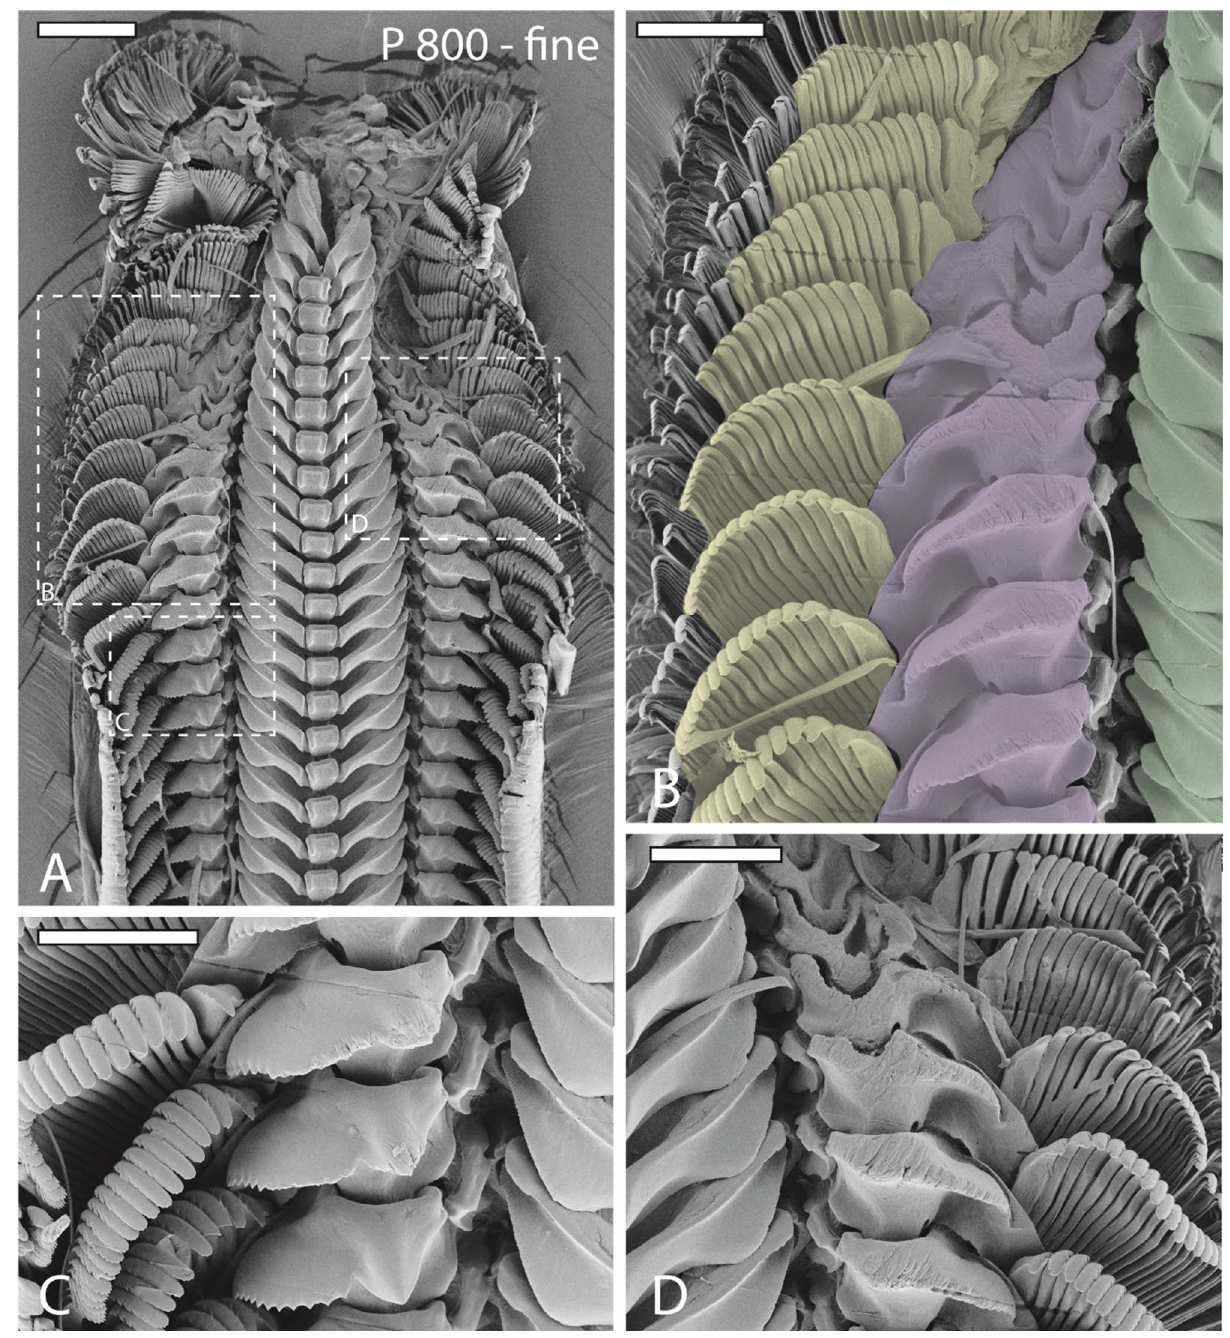
Right wear zone with colored outlines of lateral teeth I (green), lateral teeth II (purple), and inner 15 marginal teeth (yellow; only marginal teeth that show signs of wear were colored). ( C ) First signs of wear on lateral tooth I, lateral tooth II, marginal teeth. ( D ) Left wear zone. Scale bars: A = 200 μm, B–D = 100